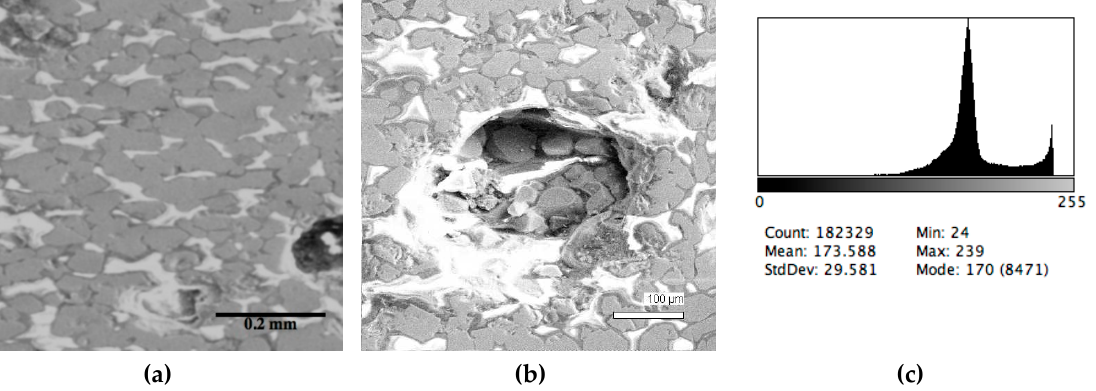
Figure 3. Typical back scattered electron images ( a , b ) of microstructures and contrast histogram ( c ) of the Sample #3 grind; SEM.